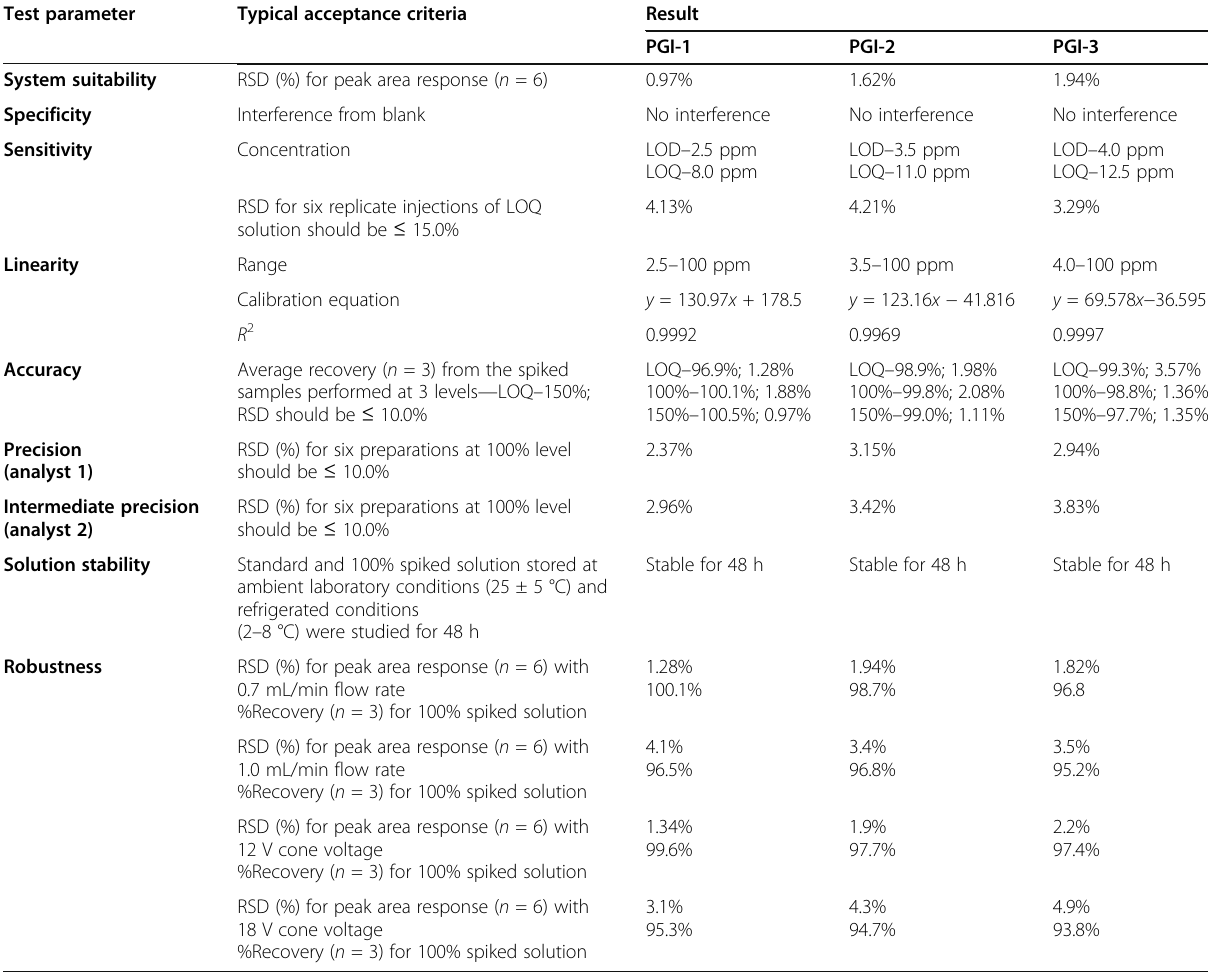
Table 2 Summary of method validation results